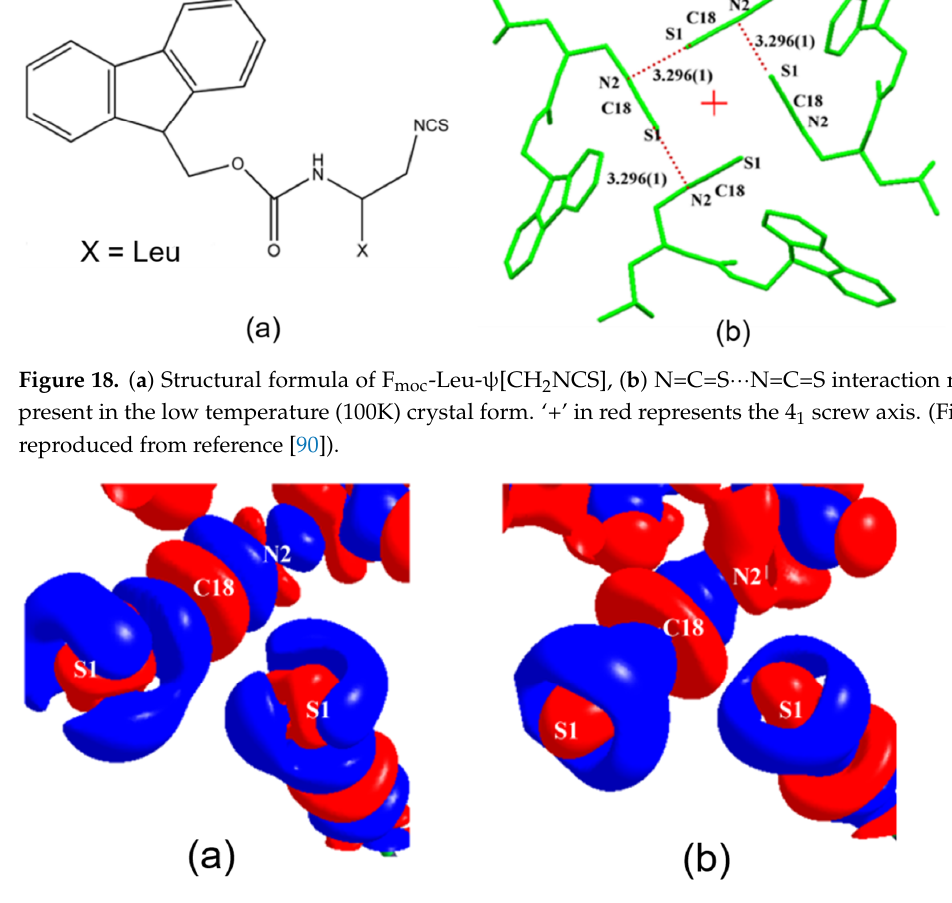
Figure 20. Electrostatic potential mapped on 0.5 eÅ −3 isodensity surface; ( a ) highlights a σ-hole on S (blue) along the extension of the N = C = S bond, ( b ) highlights a π-hole (blue) perpendicular to the C = N bond. Blue and red colours: +ve (more electropositive) and –ve regions (less electropositive), respectively. (Figure reproduced from reference [90] ). 3. Applications of Charge Density Analysis in Crystal Engineering and Pharmaceuti- cal Sciences We have demonstrated that the charge density topological features at the intermo- lecular interaction regions of the supramolecular synthons (certain recurring interaction motifs which act as supramolecular recognition units) are roughly conserved, at least in the examples we analyzed [91]. In earlier work, Munshi and Row classified hydrogen bonds into weak and strong classes on a quantitative scale based on the topological fea- tures of experimental and theoretical charge density models [92]. The charge density stud- ies on the C-H∙∙∙F, C-H∙∙∙Cl, and C-H∙∙∙Br hydrogen bonds, which were considered to be in the weak regime of interactions, revealed the strength and significance of these new